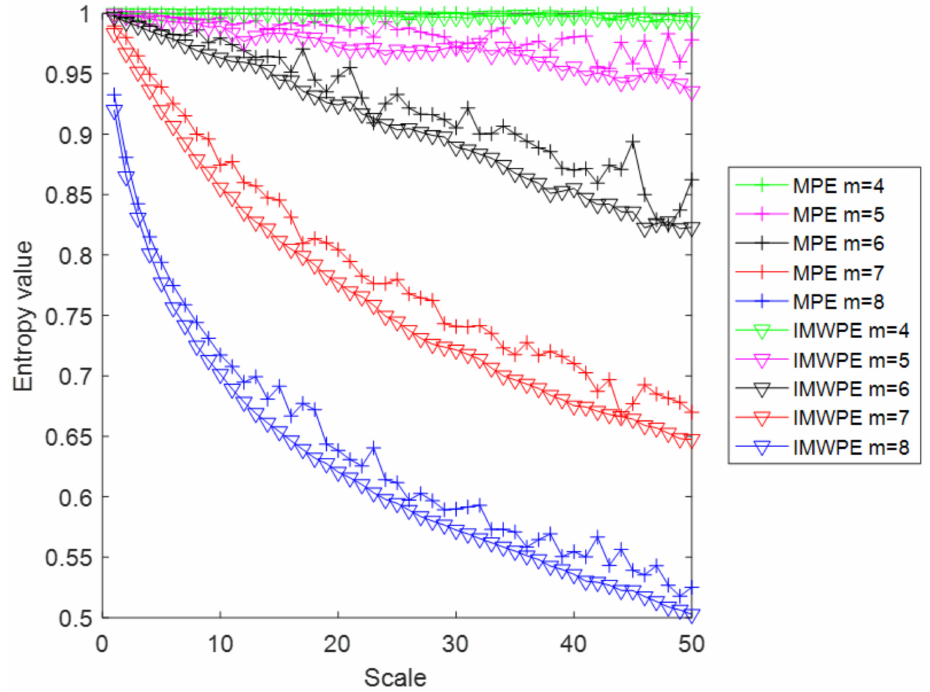
Figure 6. The entropy values of MPE and IMWPE under different dimension.